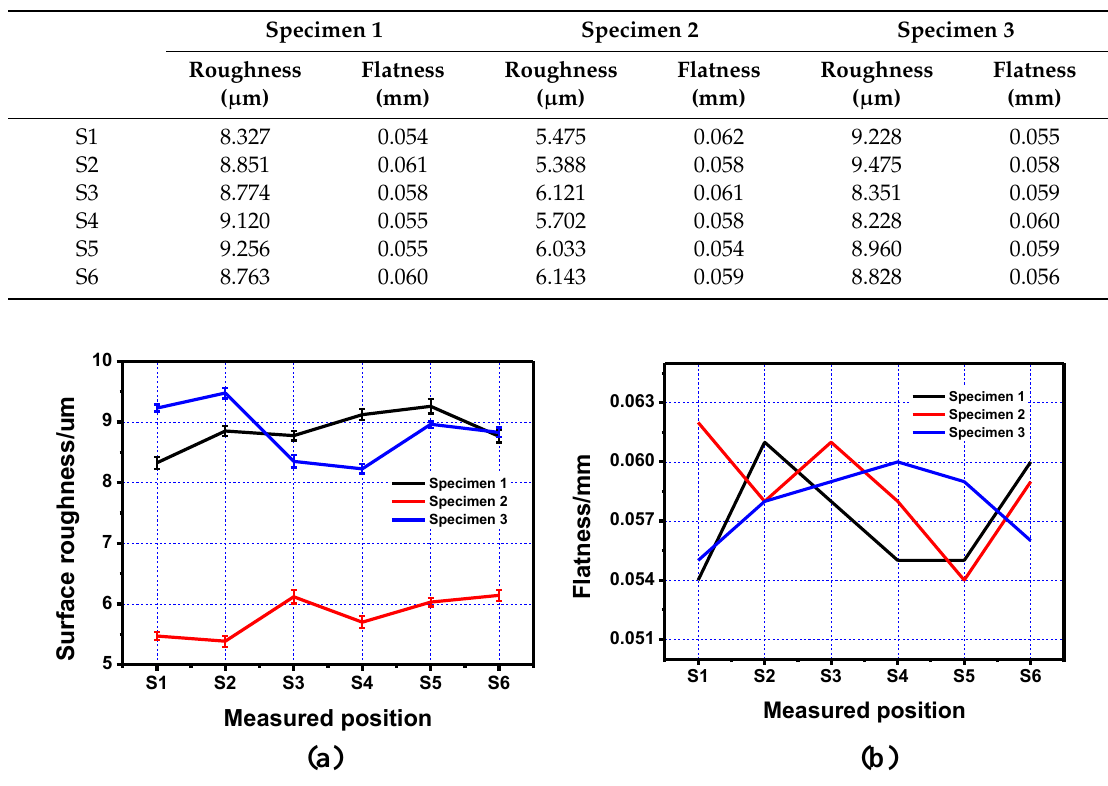
Table 4. Roughness and flatness of the side surface on the inner structure.